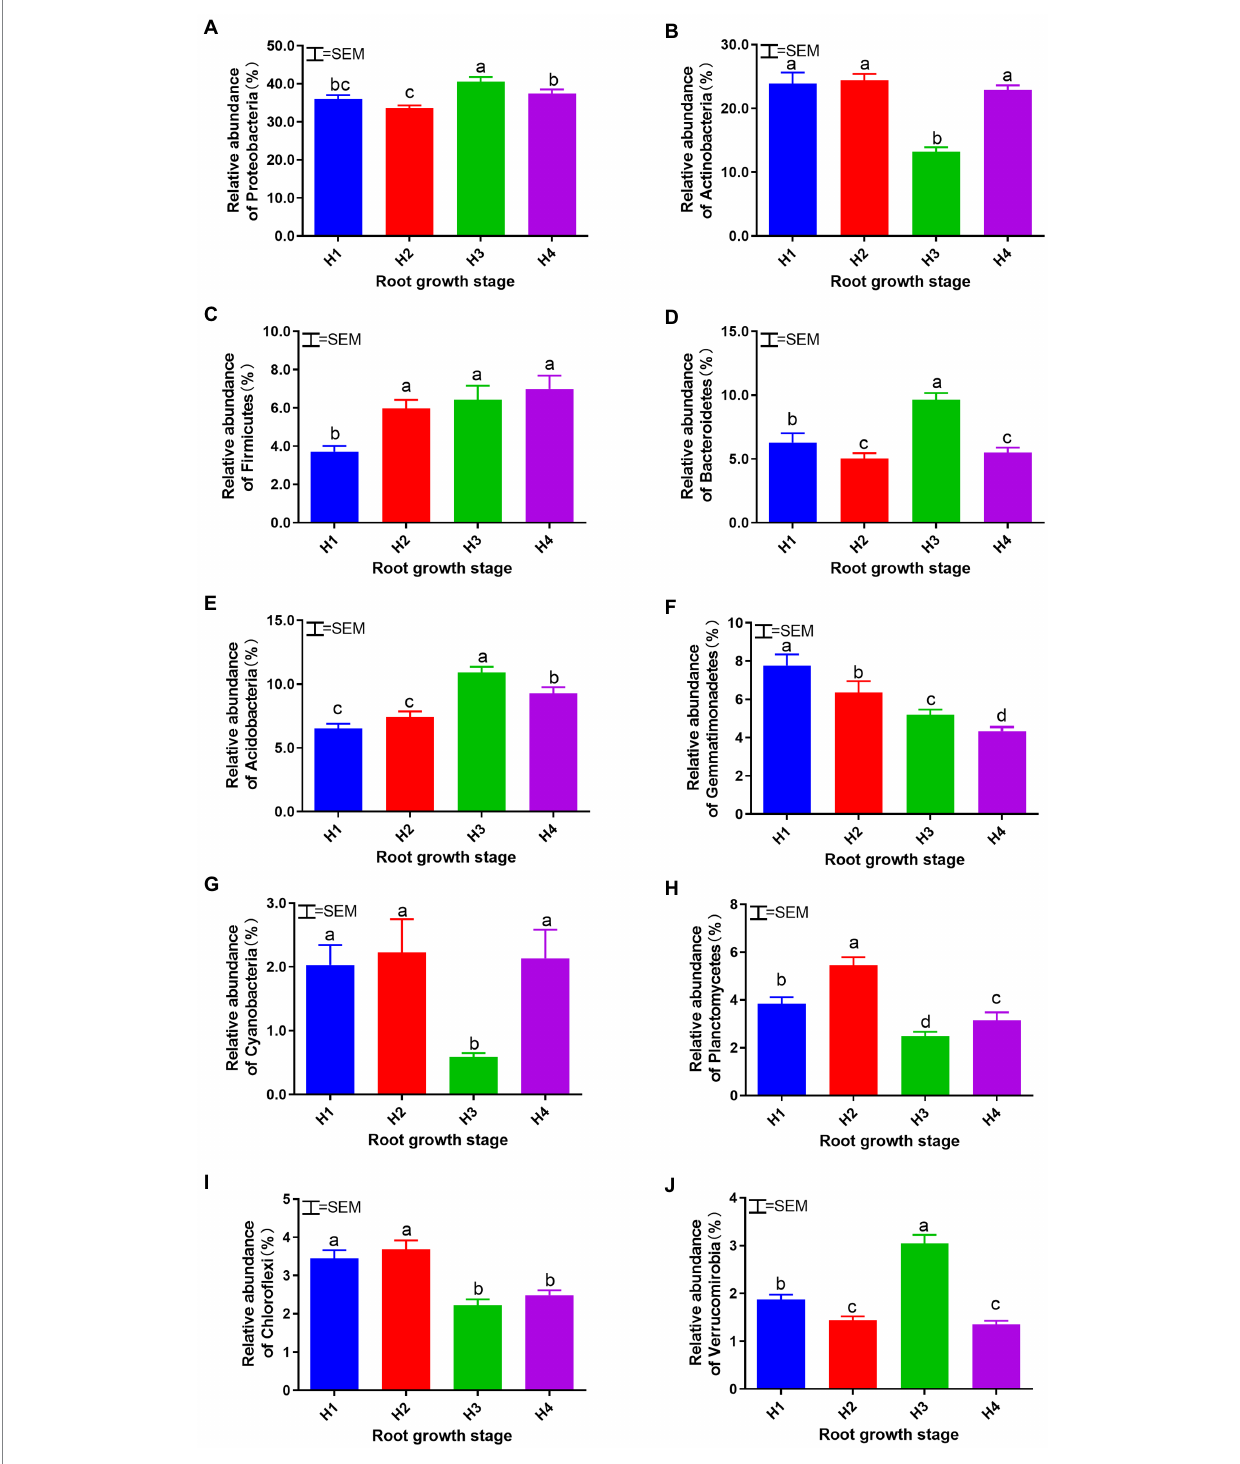
FIGURE 4 Relative abundance of dominant soil bacterial phyla: Proteobacteria (A) , Actinobacteria (B) , Firmicutes (C) , Bacteroidetes (D) , Acidobacteria (E) , Gemmatimonadetes (F) , Cyanobacteria (G) , Planctomycetes (H) , Chloroflexi (I) , and Verrucomicrobia (J) at root growth stages H1–4. H1–4, root growth stages of mixed forage: January 4 (H1), March 14 (H2), April 21 (H3), and May 19 (H4). SEM, standard error of the mean ( n = 18). Means with difference superscripts differ significantly ( p <